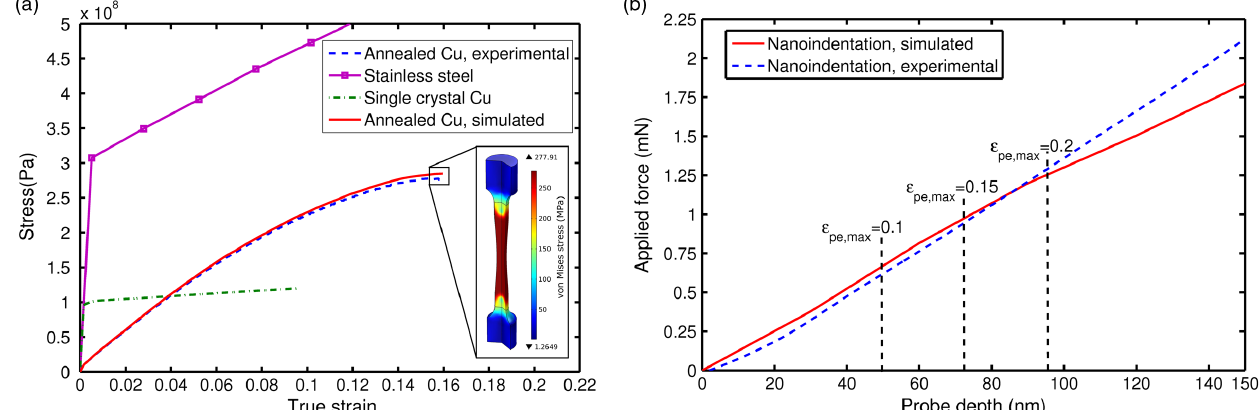
FIG. 2. Validation of the applied FEM model by simulations of mechanical tests. (a) Tensile strength test simulation for the annealed copper, single crystal copper and steel samples shaped as bars shown in the inset. The validation against the experiment is shown for annealed copper. (b) Comparison of the simulation and experimental results [38] for the nanoidentation test in single crystal copper. In the simulation the experimental geometry is fully reproduced to ensure the comparability of the results (see text for